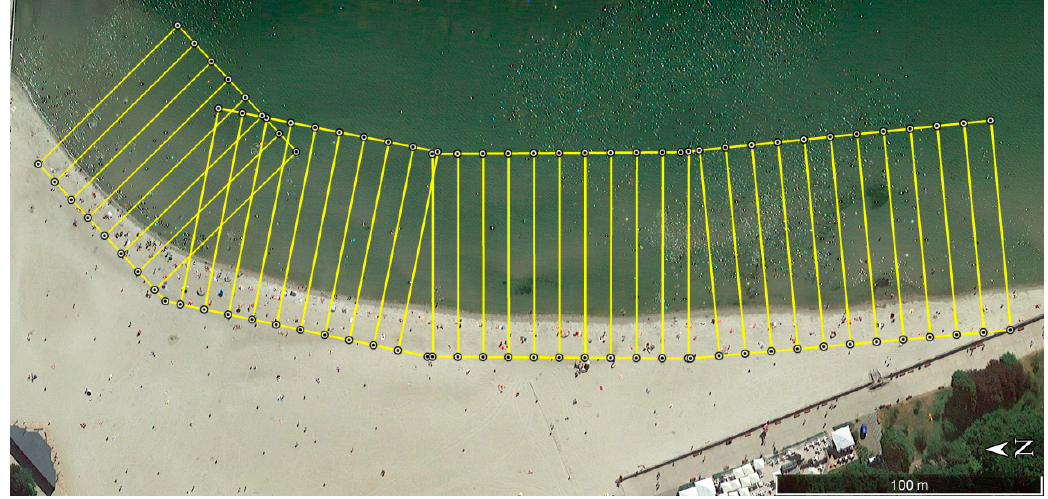
Figure 2. The planning of hydrographic profiles during baseline measurements in Gdynia.